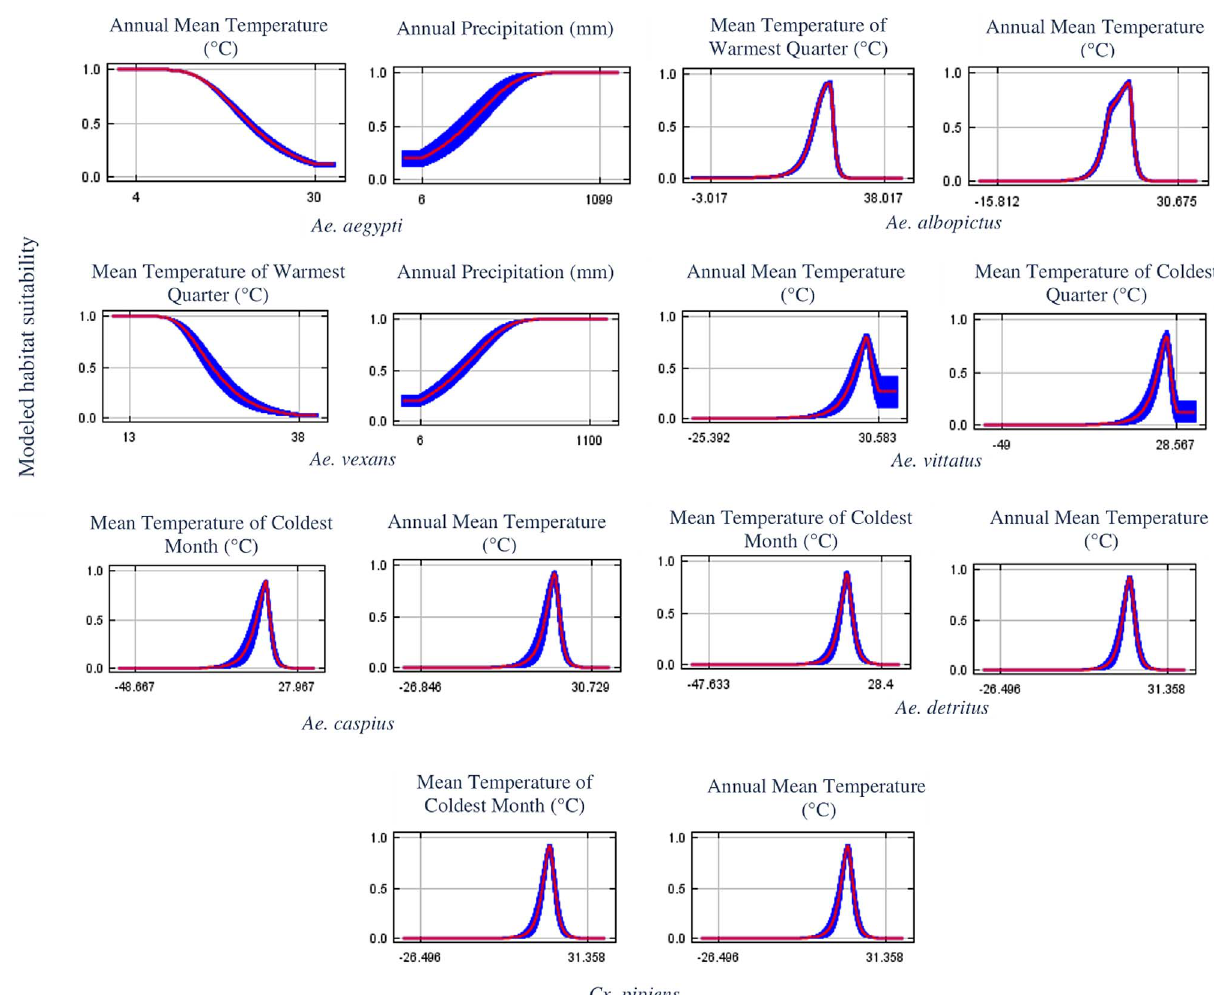
Figure 8. Response curves (for most contributing variables) for the one-variable-models indicating the environmental limits for each